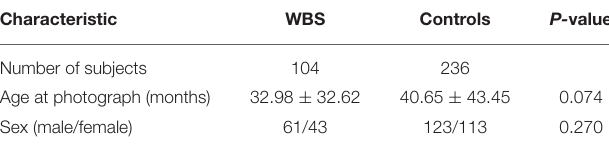
TABLE 1 | Demographic characteristics of WBS patients and control